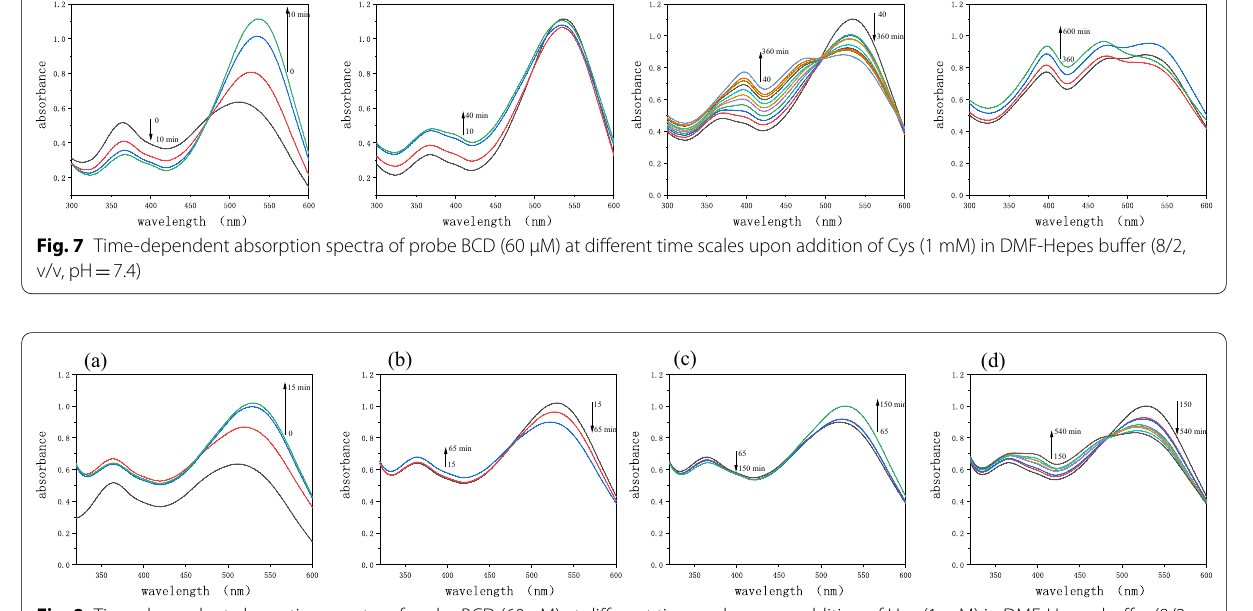
Fig. 8 Time-dependent absorption spectra of probe BCD (60 µM) at different time scales upon addition of Hcy (1 mM) in DMF-Hepes buffer (8/2, v/v, pH 7.4) =